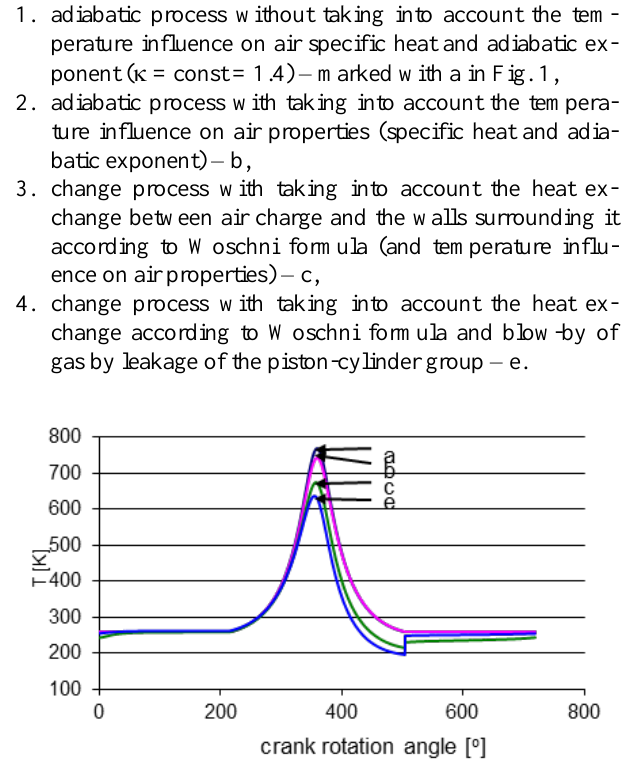
Fig. 2. The results of air temperature computation for various charge changes in AD4.236 engine